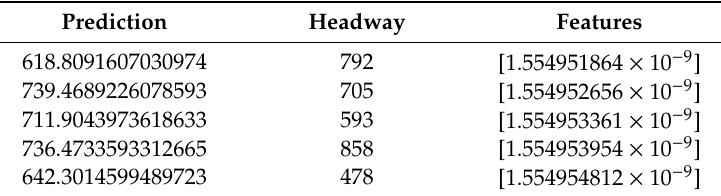
Table 5. Regression model output of bus service headways using Spark